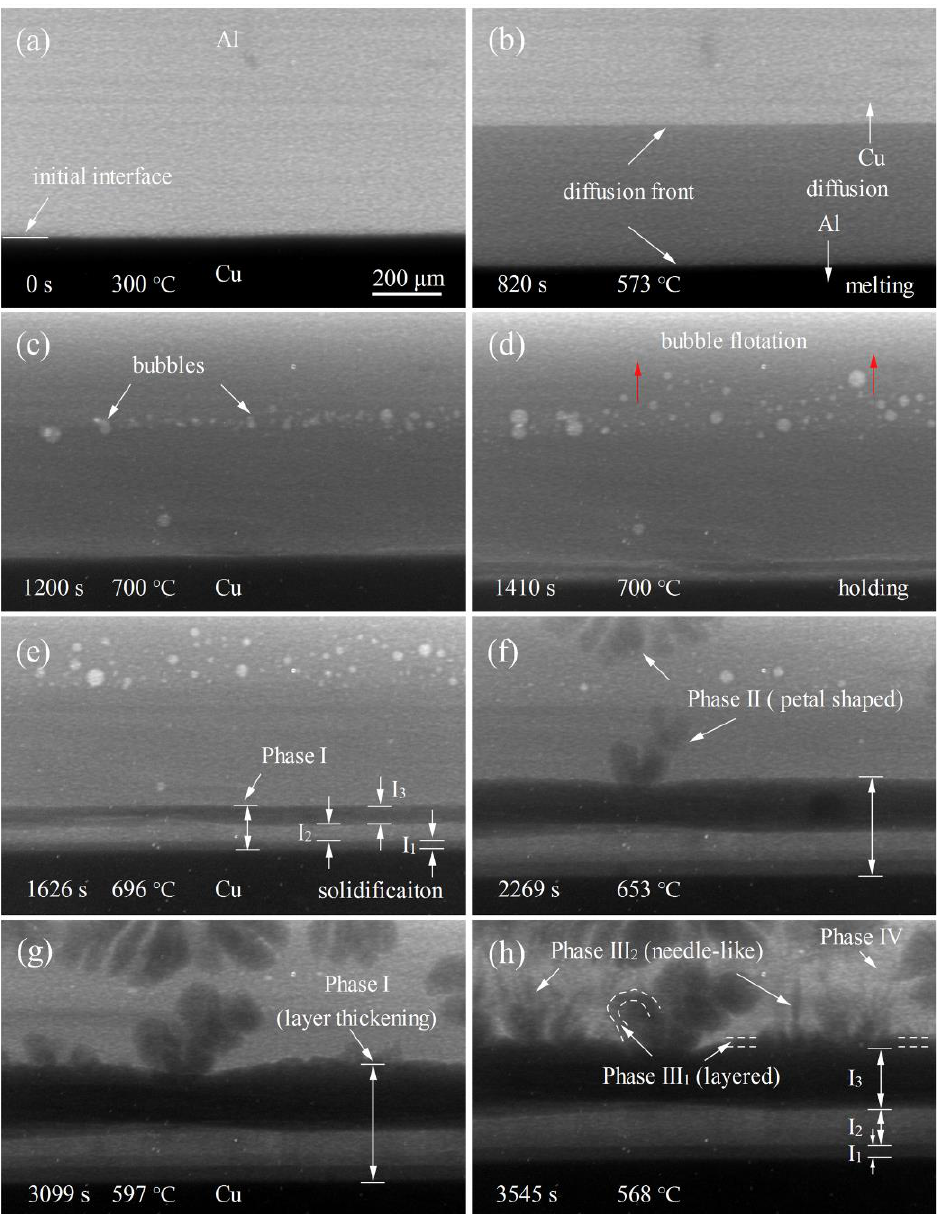
Figure 2. Sequence of in situ radiographs showing the interfacial diffusion and microstructure evolution in the Al/Cu sample: ( a – d ) the melting and holding process ( t = 0 s is assigned to the onset of image collection at 300 °C), ( e – h ) the solidification process after holding at 700 °C for 5 min.